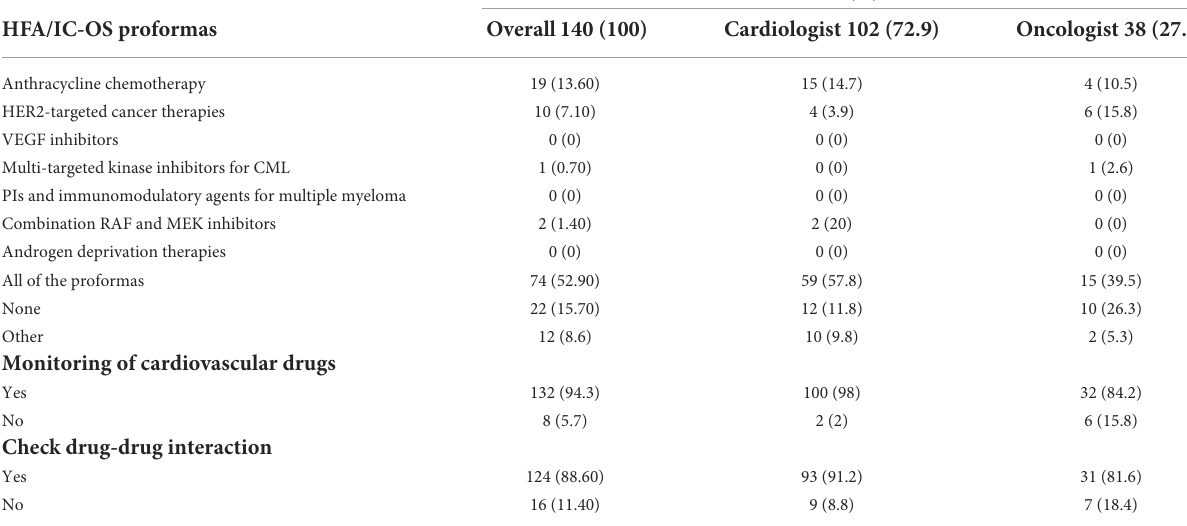
TABLE 2 Baseline cardiovascular risk stratification, drug monitoring, and drug interaction in cardio-oncology. Risk